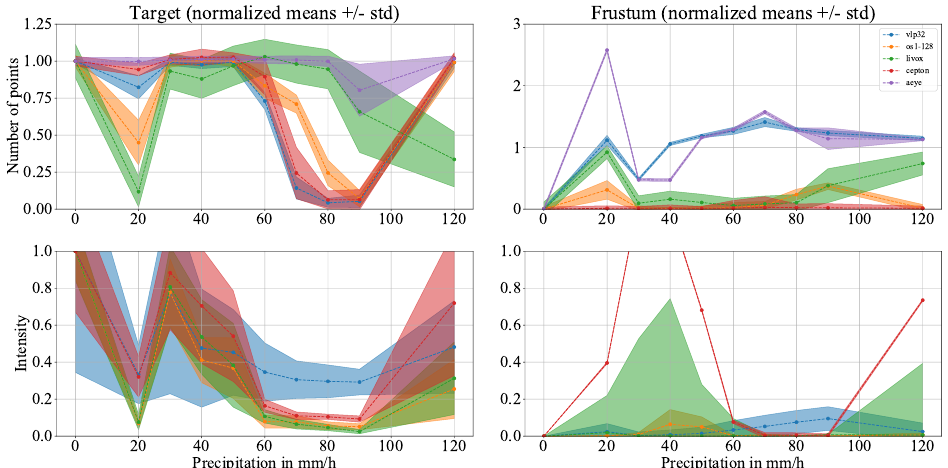
Figure 12. Sensors behaviors under rainy